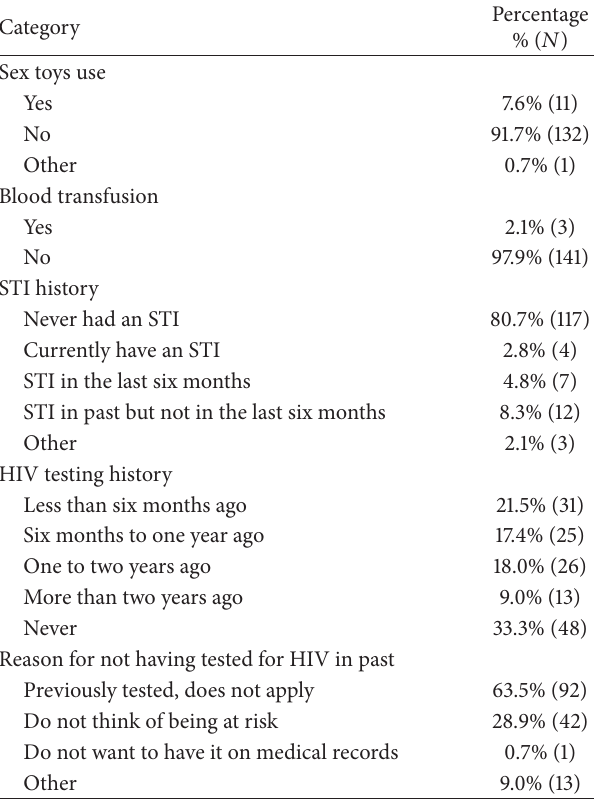
Table 1: Demographic characteristics and STI risk level of study population ( 𝑁 = 145